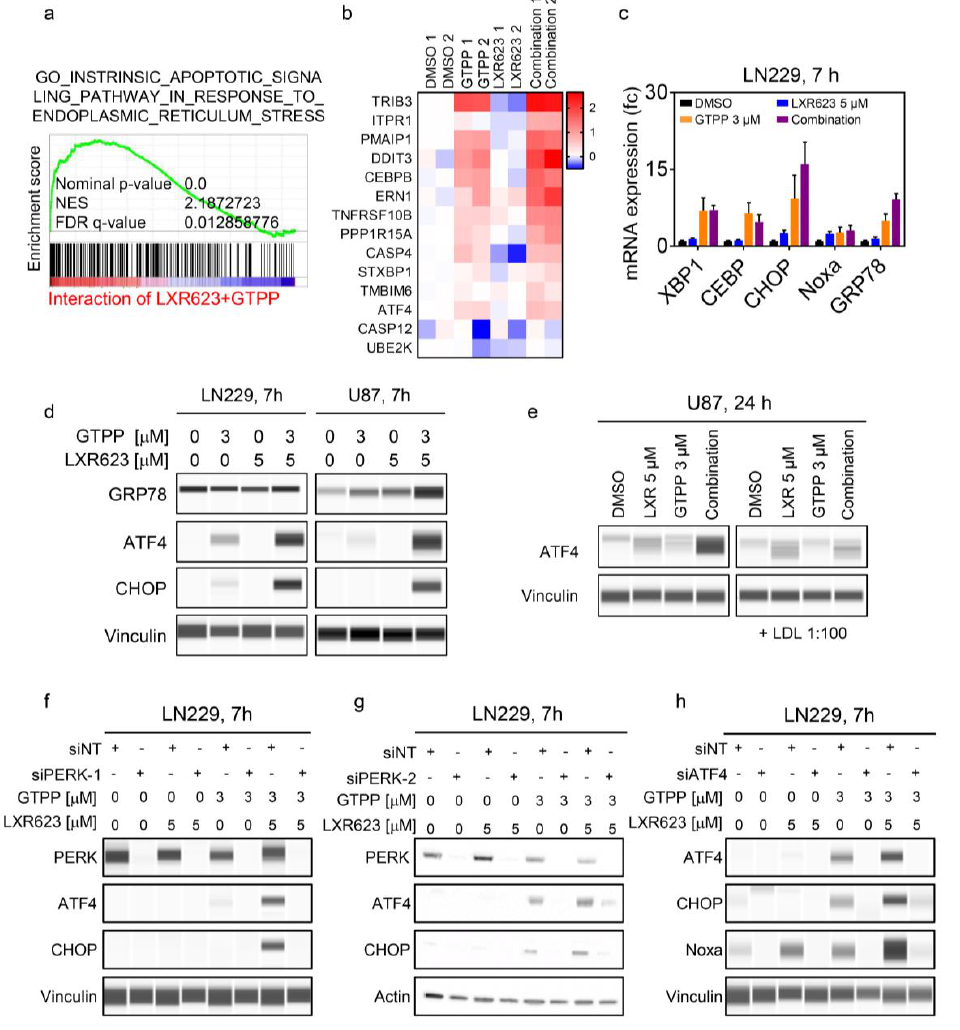
Figure 5. Gamitrinib and LXR623 elicit synergistic activation of the integrated stress response to